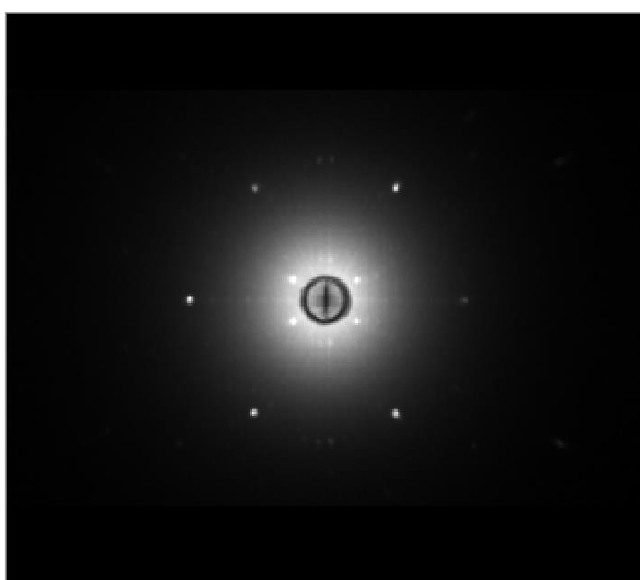
Figure 4. Laue patterns on ab plane of the TbInO 3 crystal.